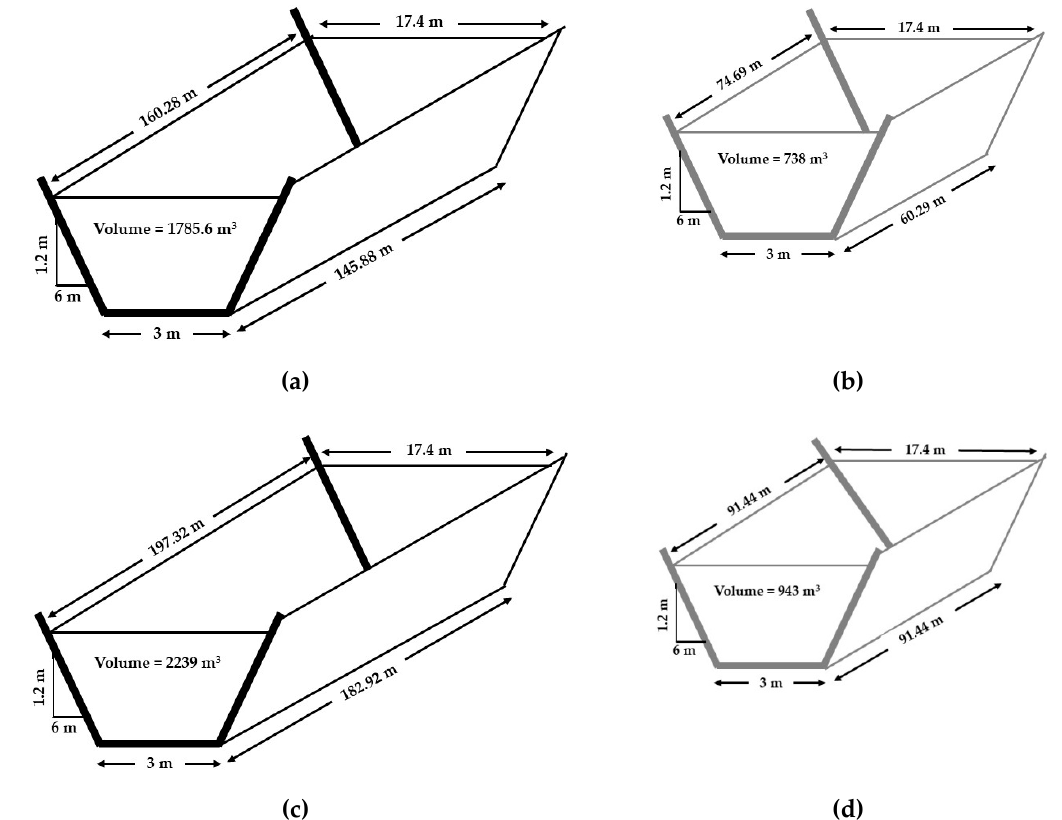
Figure 3. Detention basin dimension for minor storm ( a ) conventional and ( b ) hybrid drainage system and major storm ( c ) conventional and ( d ) hybrid drainage system.